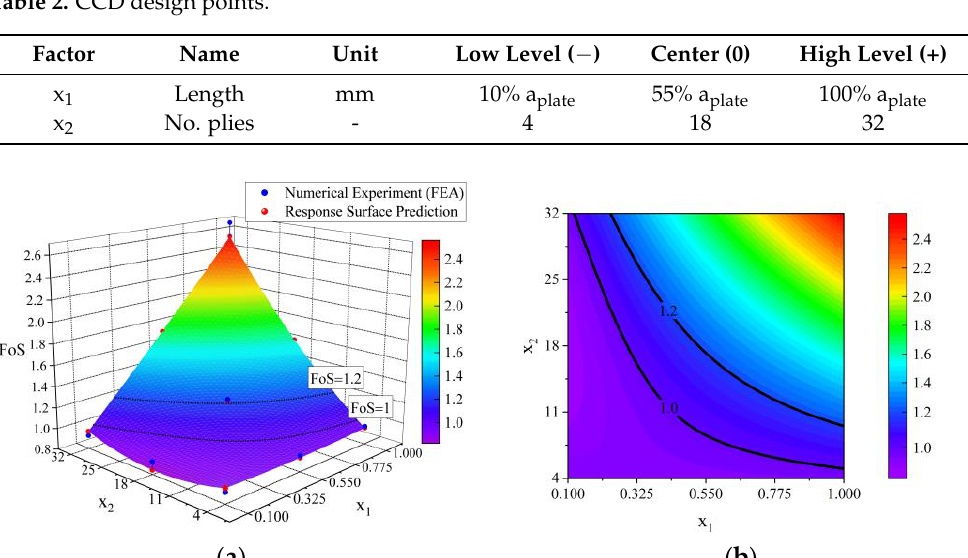
Table 2. CCD design points.